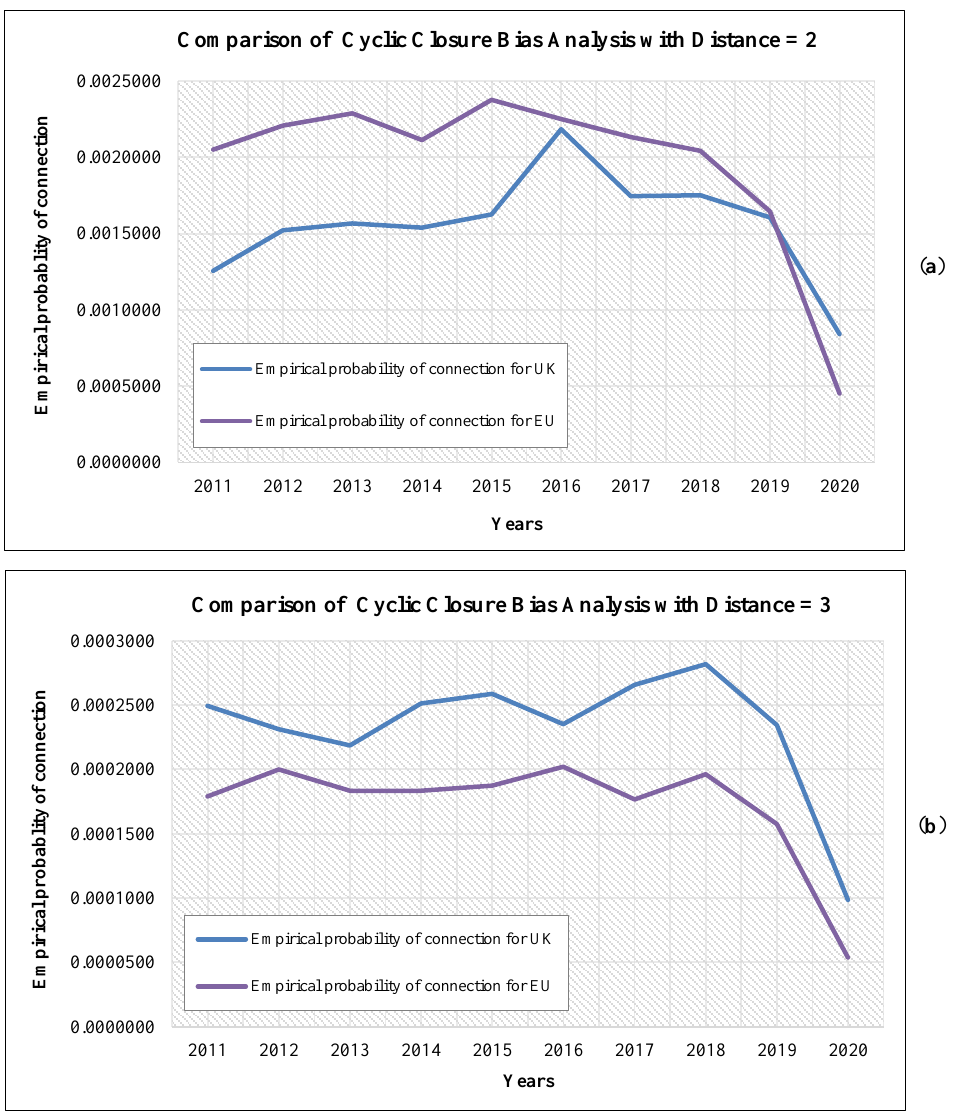
Figure 5. Comparison Analysis for Cyclic Closure Bias: (a) Cyclic Closure Bias with Distance = 2; (b) Cyclic Closure Bias with Distance =